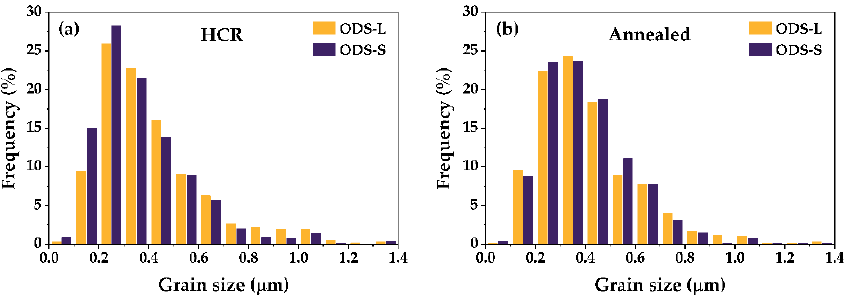
Figure 5. Grain size distribution measured from SEM images on the TS plane for the ODS-L and ODS-S steels: ( a ) after HCR; ( b ) after annealing at 1273 K.